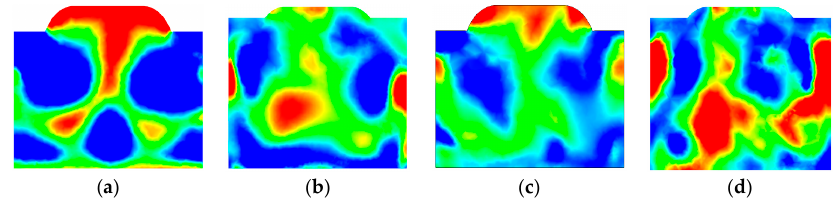
Figure 4. Velocity field in X velocity at 145° BTDC. ( a , b ) Averaged velocity field for RANS at Y = − 6 mm and Y = − 10 mm, respectively; ( c , d ) instantaneous velocity field for improved delayed detached eddy simulation shear-stress transport (IDDES-SST) at Y = − 6 mm and Y = − 10 mm, respectively.